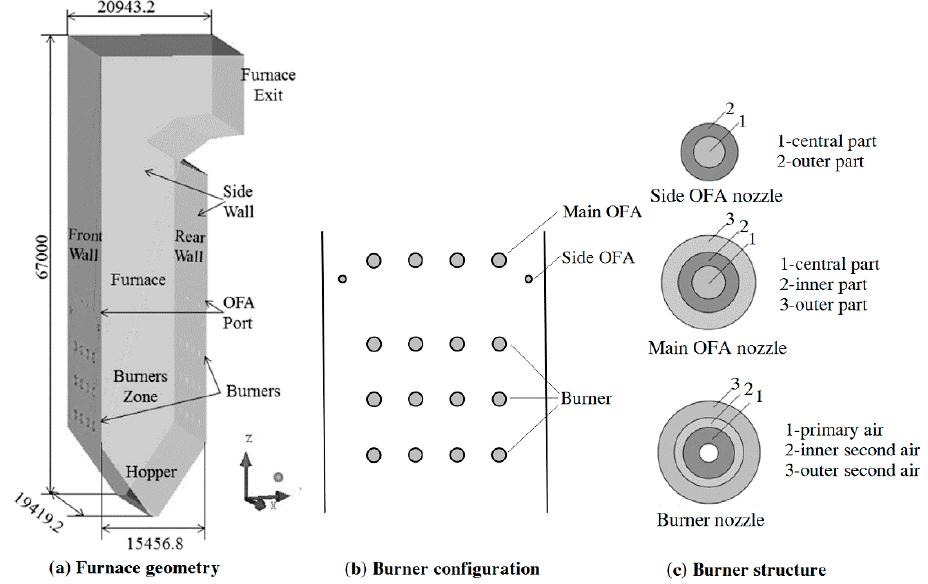
Figure 1. The detailed configuration of the wall-fired boiler. OFA: over fire air.